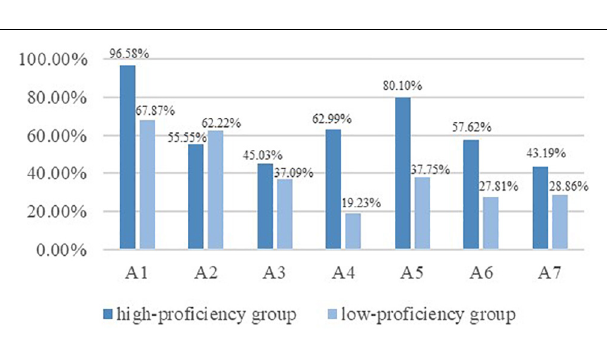
FIGURE 3 | Relationship structure of translation competence attributes.